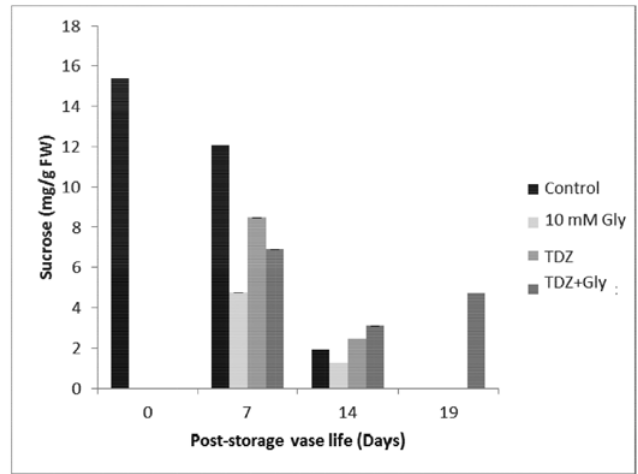
Fig. 5 - Sucrose content measured in leaves of cut Danae branches treated with distilled water (control), 10 mM Glycerol, 10 µM TDZ or 10 µM TDZ plus 10 mM Glycerol during vase life. Values are means with standard errors ( n =3).